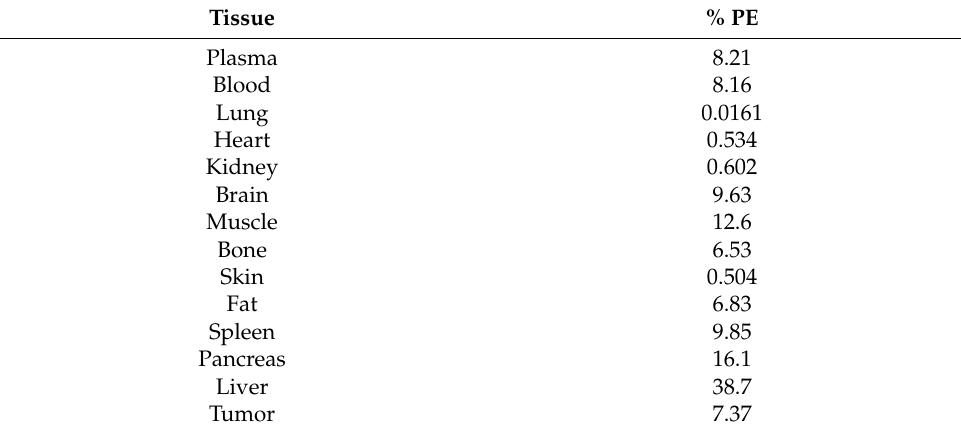
Table 4. Percentage predictive errors for the quantitative comparison of observed and PBPK model predicted MMAE PK profiles.